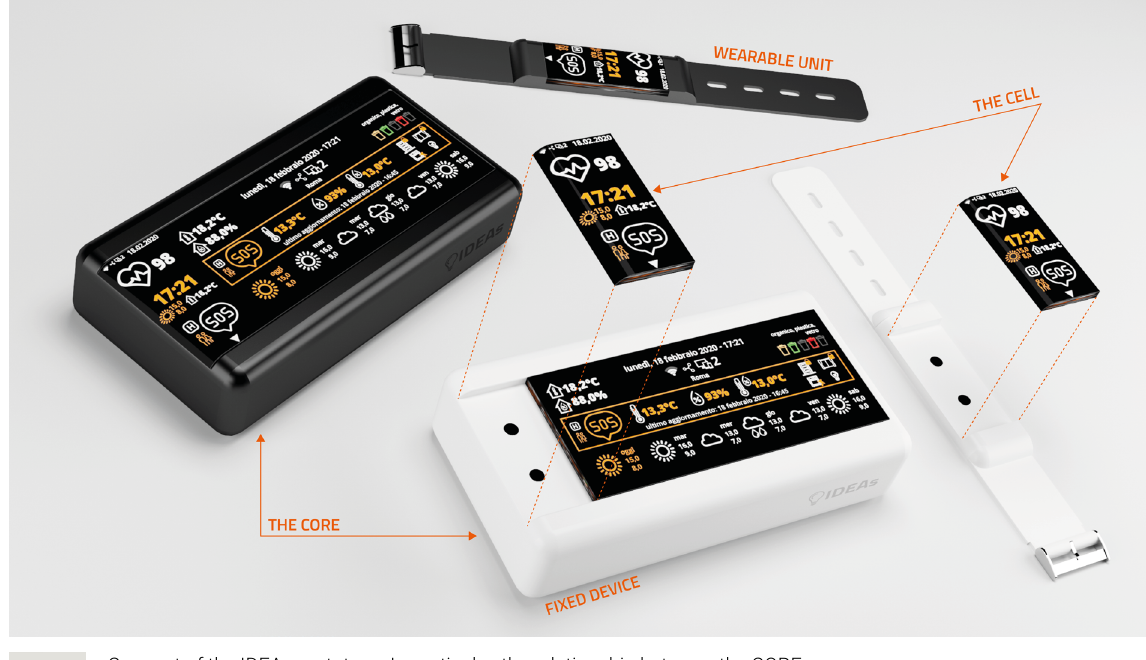
FIG. 3 Concept of the IDEAs prototype. In particular, the relationship between the CORE and the CELL that can be mounted on a wearable support is shown Source: